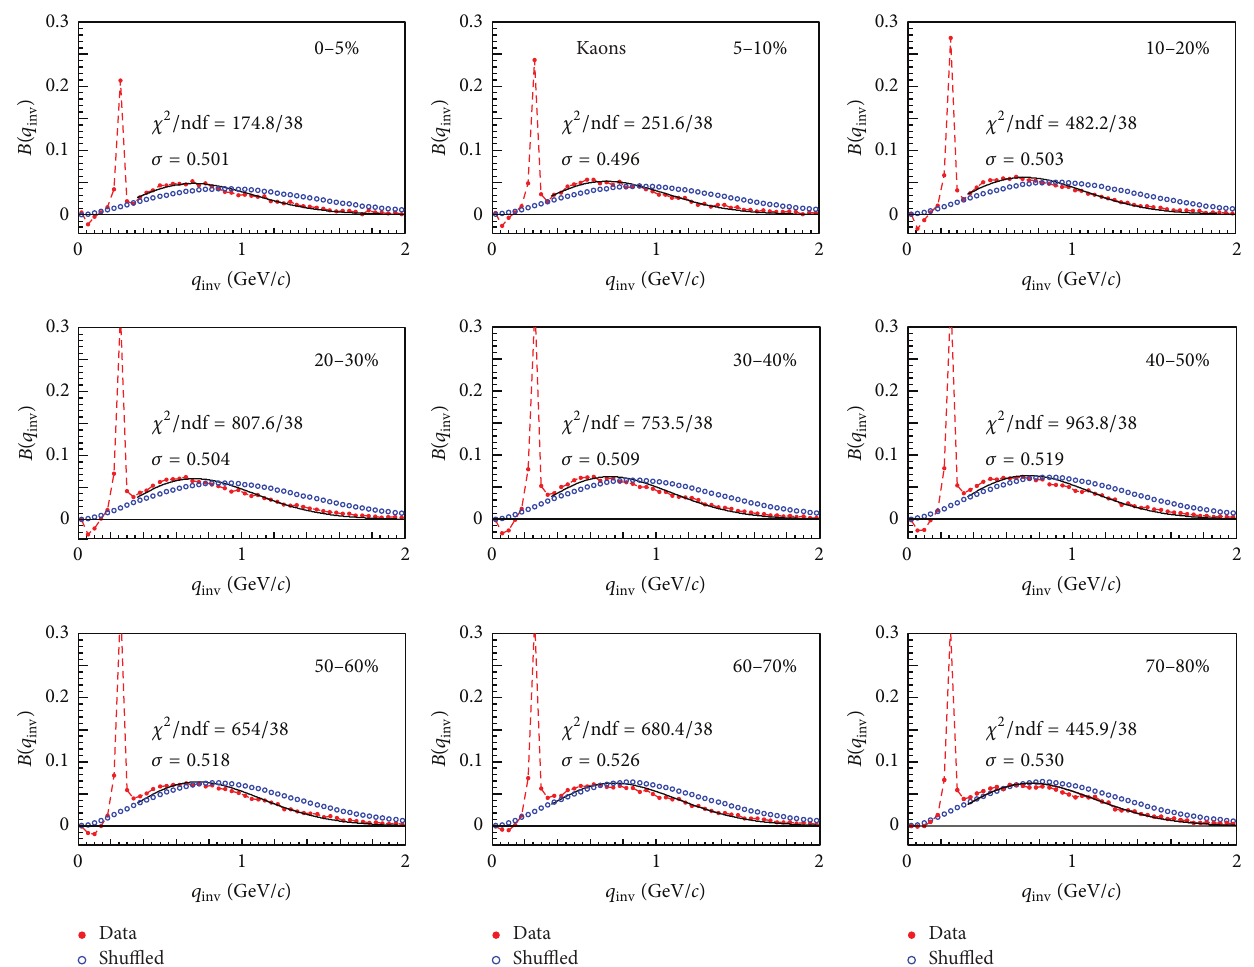
= 200 GeV in different centrality bins. NN